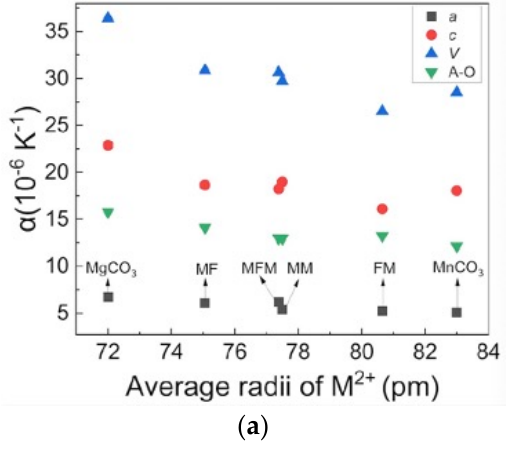
Figure 5. ( a ) Thermal expansion of MFM, MF, FM, MM, MgCO 3 , and MnCO 3 with the change of the average ion radii. Data from Markgraf and Reeder, 1985, and Liang et al., 2020 [19,35]. ( b ) The equation of the relationship between the content of Fe 2+ and Mn 2+ and the thermal expansion α V with the change of the average ion radius of MFM, MF, FM, MM.